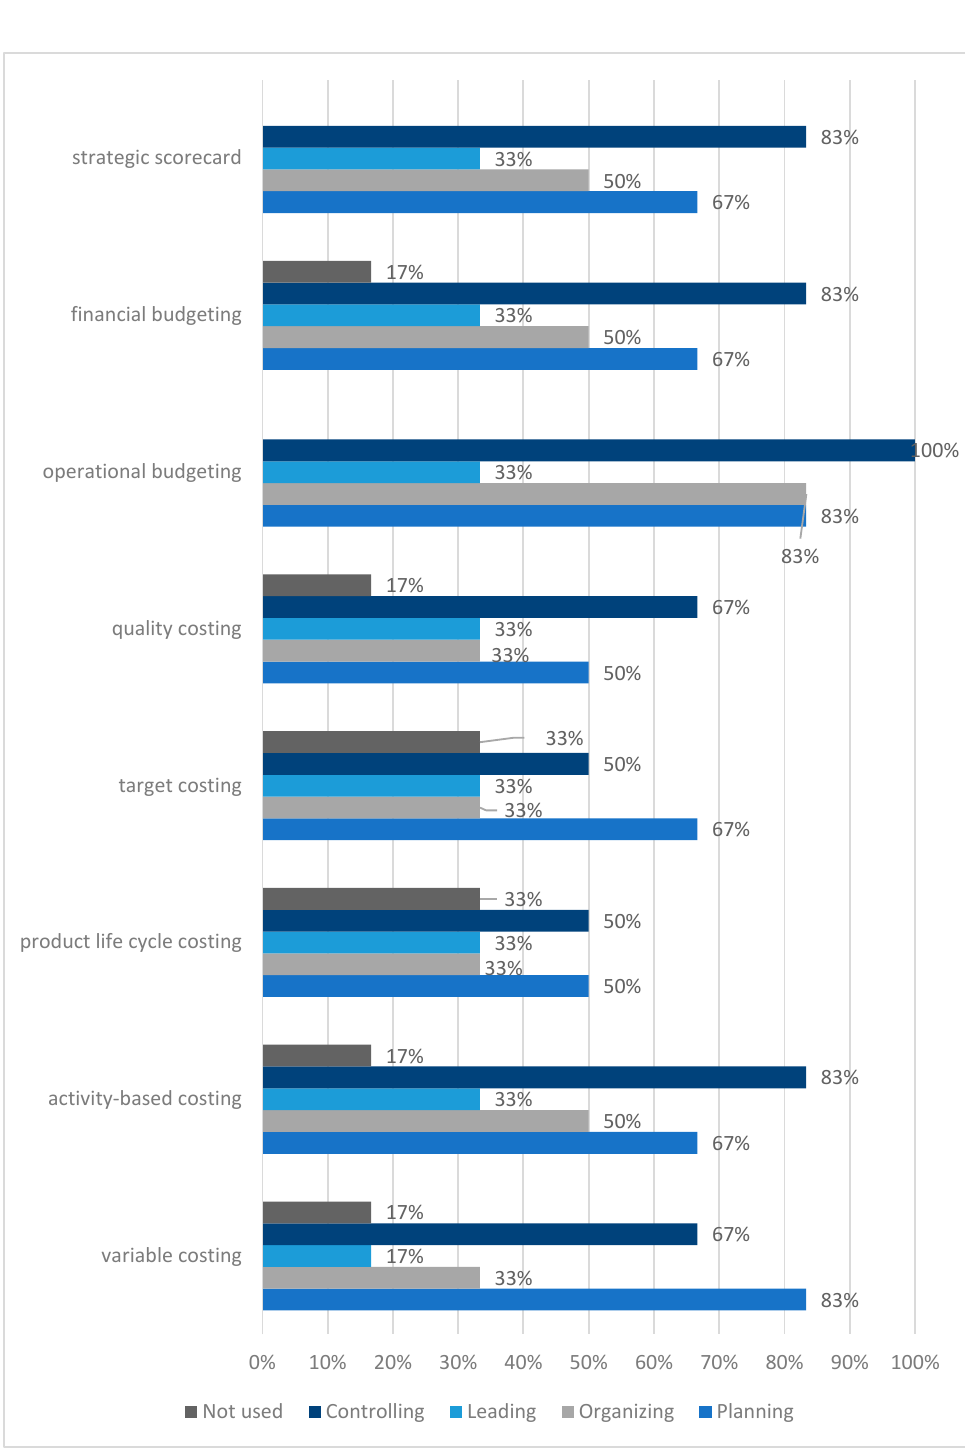
Figure 2. Planning decisions in the entities surveyed: up to 1 year, for 2–3 years, over 3 years. Source: own elaboration